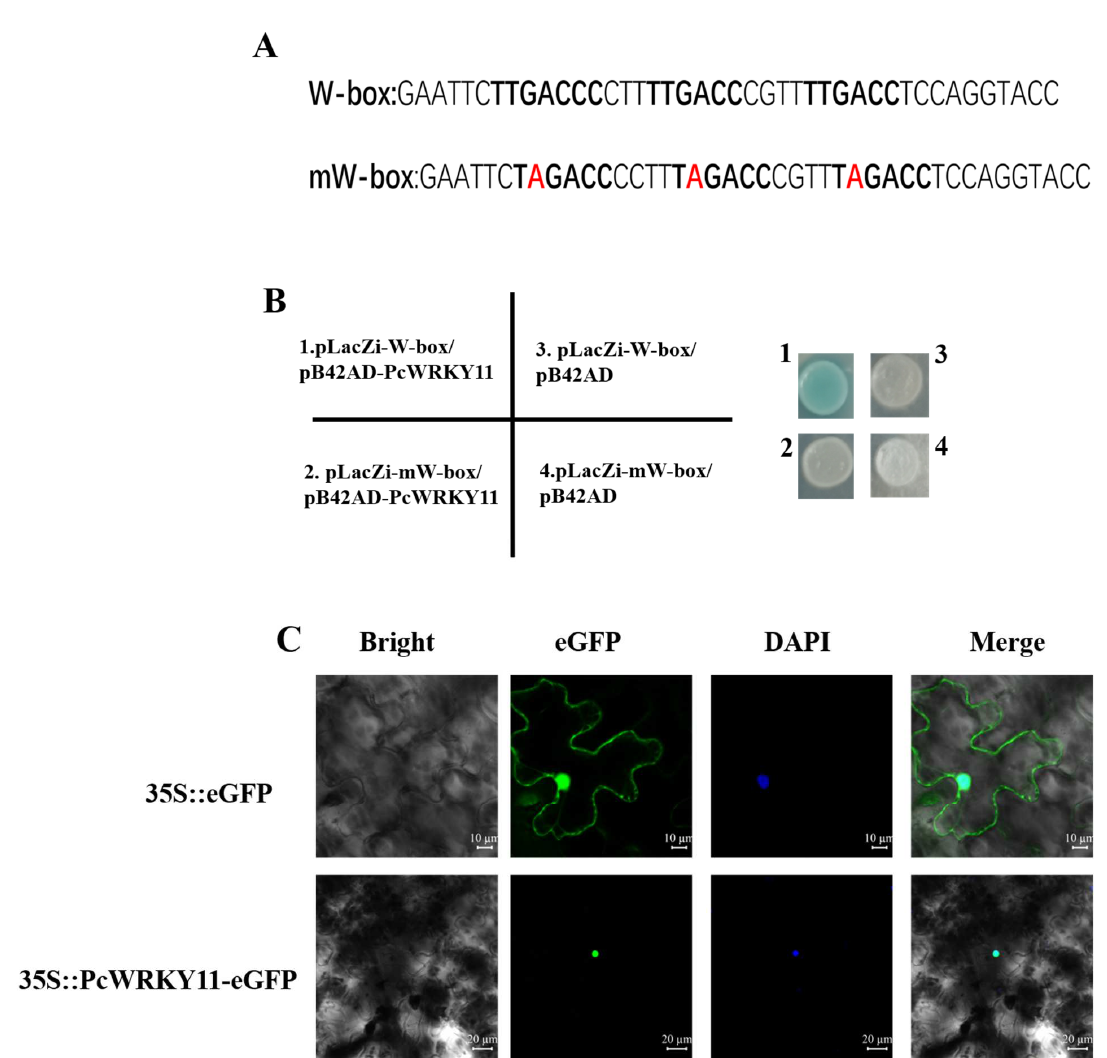
Figure 3. Analysis of PcWRKY11 transcriptional activation activity. ( A ) Nucleotide sequence of W-box and mW-box. Red letters represent mutant nucleotides ( B ) Yeast one-hybrid assay. The chromogenic results of the yeast one-hybrid assay. 1, pLacZi-W-box / pB42AD-PcWRKY11 ; 2, pLacZi-mW-box / pB42AD-PcWRKY11 ; 3, pLacZi-W-box / pB42AD ; 4, pLacZi-mW-box / pB42AD . ( C ) Subcellular localization of PcWRKY11 in tobacco cells. PcWRKY11-eGFP fusion protein and eGFP control were transiently expressed in N. benthamiana epidermal cells. A confocal laser scanning microscope was used for